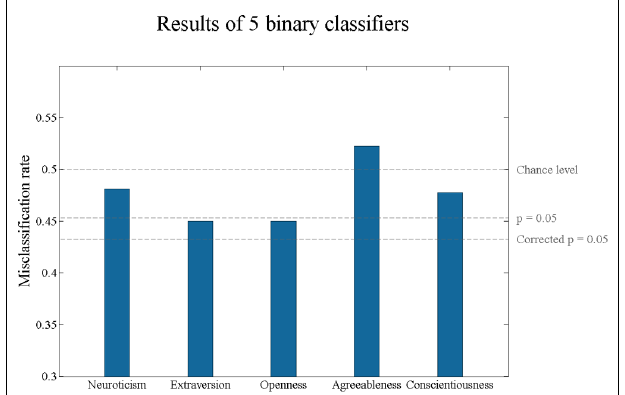
FIGURE 1 | Misclassification rates of Big Five personality traits. The personality scores have been binarized with a median-split. None of the misclassification rates of five personality traits is statistically significant after Bonferroni or false discovery rate correction at